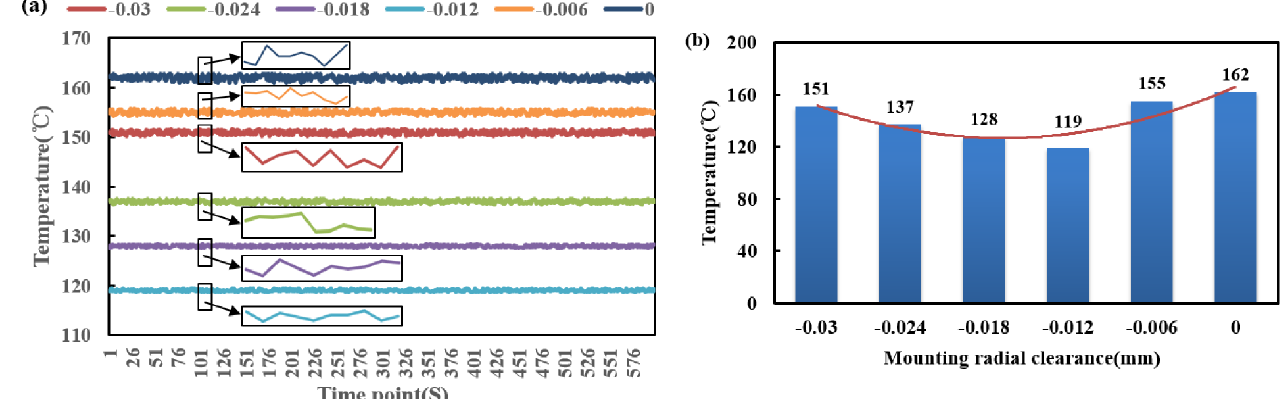
Fig. 14. Bearing temperature under the different mounting radial clearances: (a) Time point temperature in the stable phase; (b) average